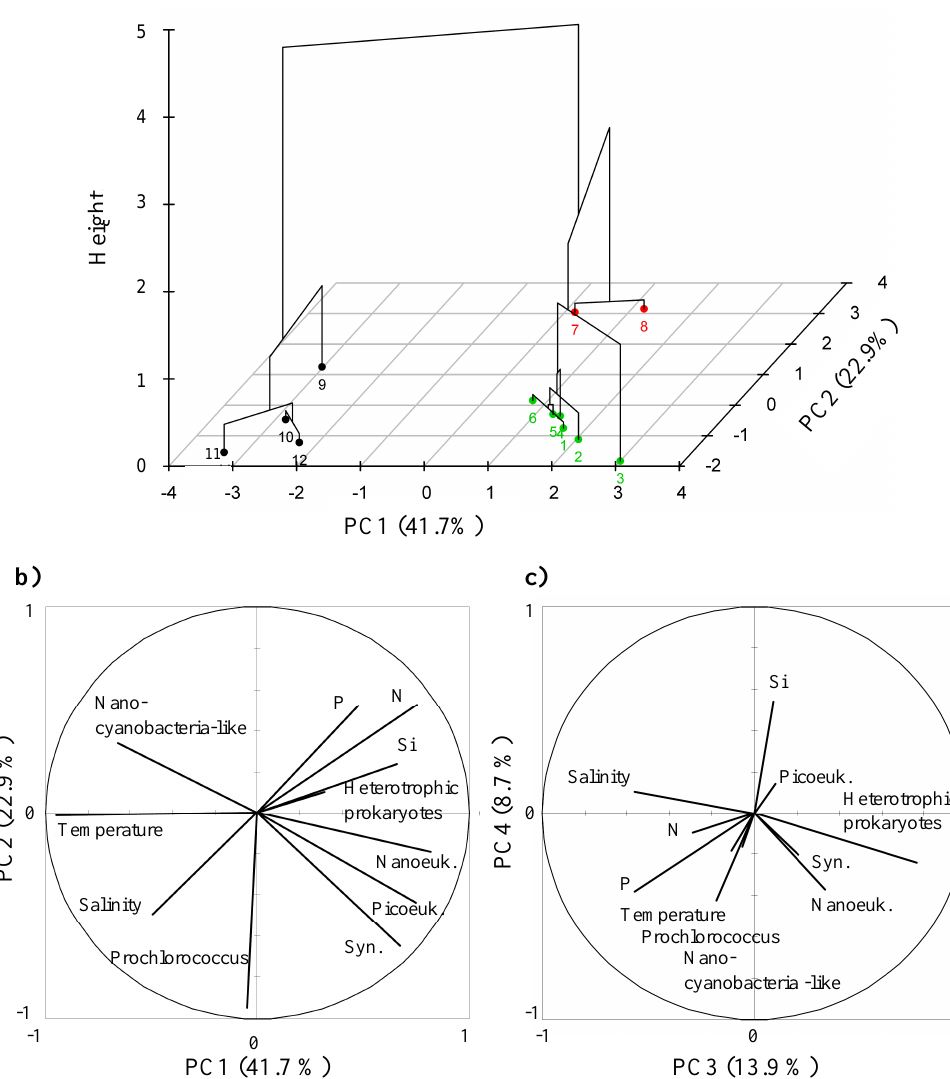
Fig. 13. Determination of the three groups of stations (1–6, 7–8, and 9–12) as identified by the hierarchical clustering (a) performed on the various parameters measured at the surface: temperature, salinity, nutrients (phosphate (P), nitrate (N) and silicic acid (Si)), the heterotrophic prokaryotes and the ultraphytoplankton (Nanocyanobacteria-like, Prochlorococcus , Synechococcus (Syn.), picoeukaryotes (Picoeuk.), Na- noeukaryotes (Nanoeuk.)). The circle (b) of correlation displays the two first dimensions of the Principal Component Analysis (PCA) and the circle (c) the dimensions 3 and